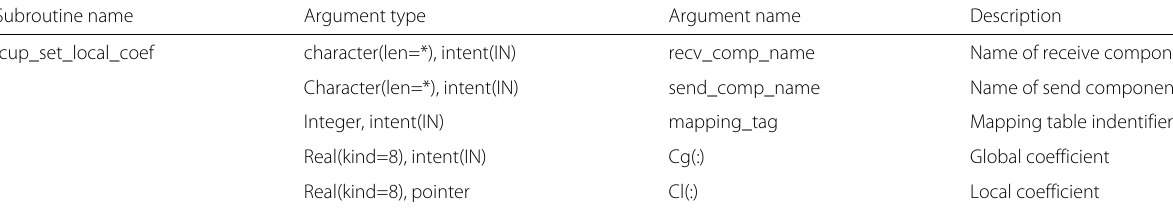
Table 4 Interface of